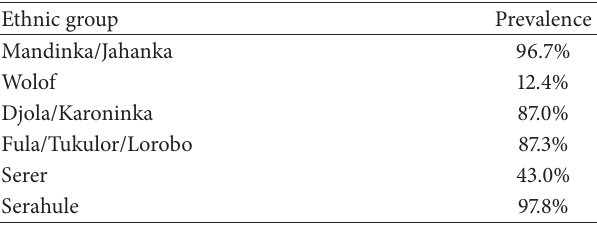
Table 2: FGM/C prevalence rates per ethnic group. Ethnic